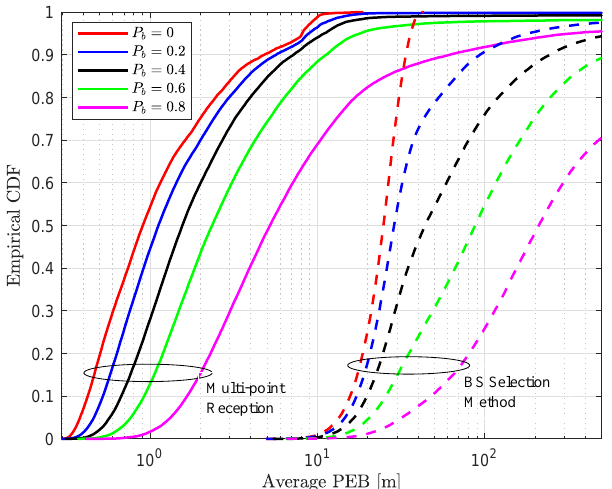
Figure 6. Empirical CDF of average positioning accuracy with different link blocking probabilities P b and uplink transmit power P t = 15 dBm for multi-point reception (solid line) and BS selection method (dashed